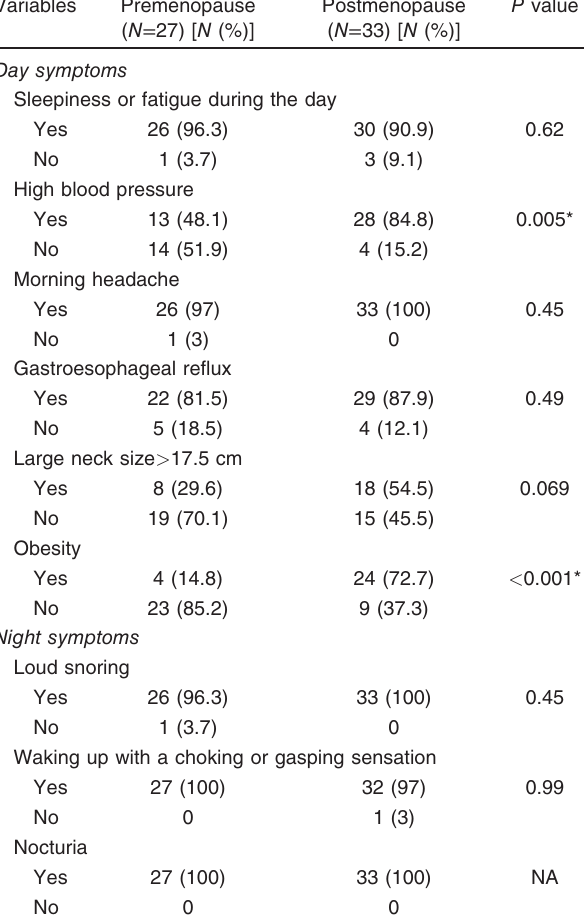
Table 3 Clinical assessment including day and night symptoms of the study groups Variables